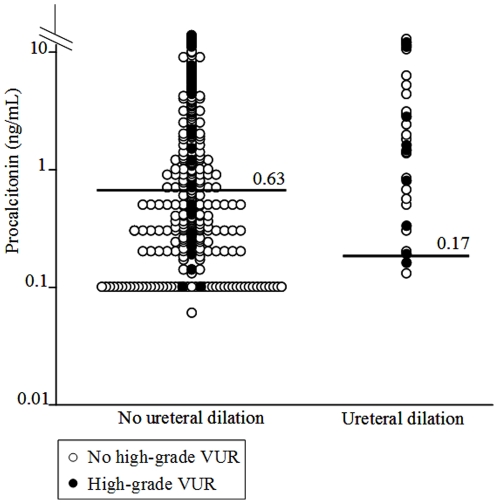
Distribution of Procalcitonin values according to the presence of high-grade VUR and the presence of Ureteral dilation on renal ultrasonography.The horizontal lines are the dichotomization threshold in each group.